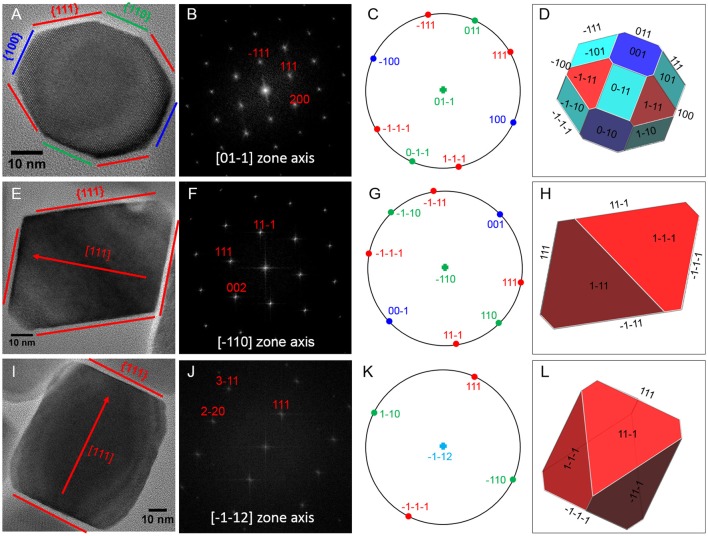
HRTEM analyses of three representative SHHC-1 magnetosomes: (A) an immature magnetosome recorded from a [0–11] zone axis, (E) a mature magnetosome recorded from a [–110] zone axis, and (I) a mature magnetosome recorded from a [–1–12] zone axis. The first column shows HRTEM images of individual magnetosomes (A,E,I); the second column shows their corresponding indexed Fast Fourier Transforms (FFT) patterns (B,F,J); the third columns shows stereographic projections (C,G,K); and the forth columns shows the morphological modes (D,H,L). For mature magnetosomes (E,I), the outlines and lattice fringes of the magnetosomes in their HRTEM images are consistent with the octahedrons based only on {111} faces. The immature one (A) has a cuboctahedral-like shape based on {111}, {110}, and {100} faces.